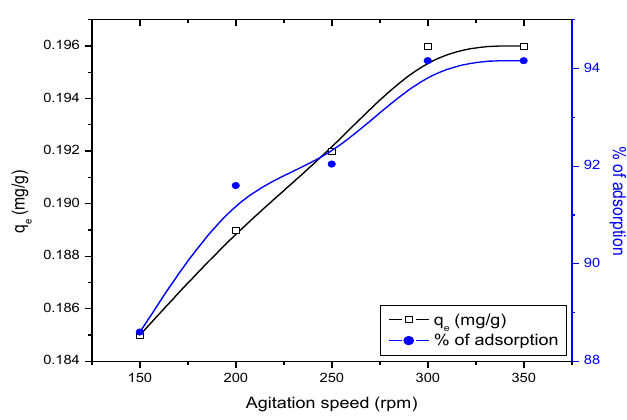
Figure 7. Effect of agitation speed on the adsorption of fluoride by eggshell powder (experimental conditions: Initial fluoride concentration: 5.0 mg/L, pH: 6.0, adsorbent dose: 2.4 g/100ml and particle size 150µm, agitation speed: 250 rpm, Contact time: 60 minutes, Temperature: 303 K).